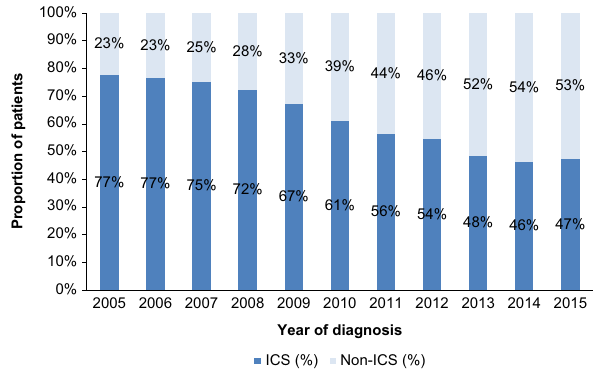
Fig. 2 Prescribing of ICS vs. non-ICS-containing therapies over time (as a percentage of maintenance treatment). ICS